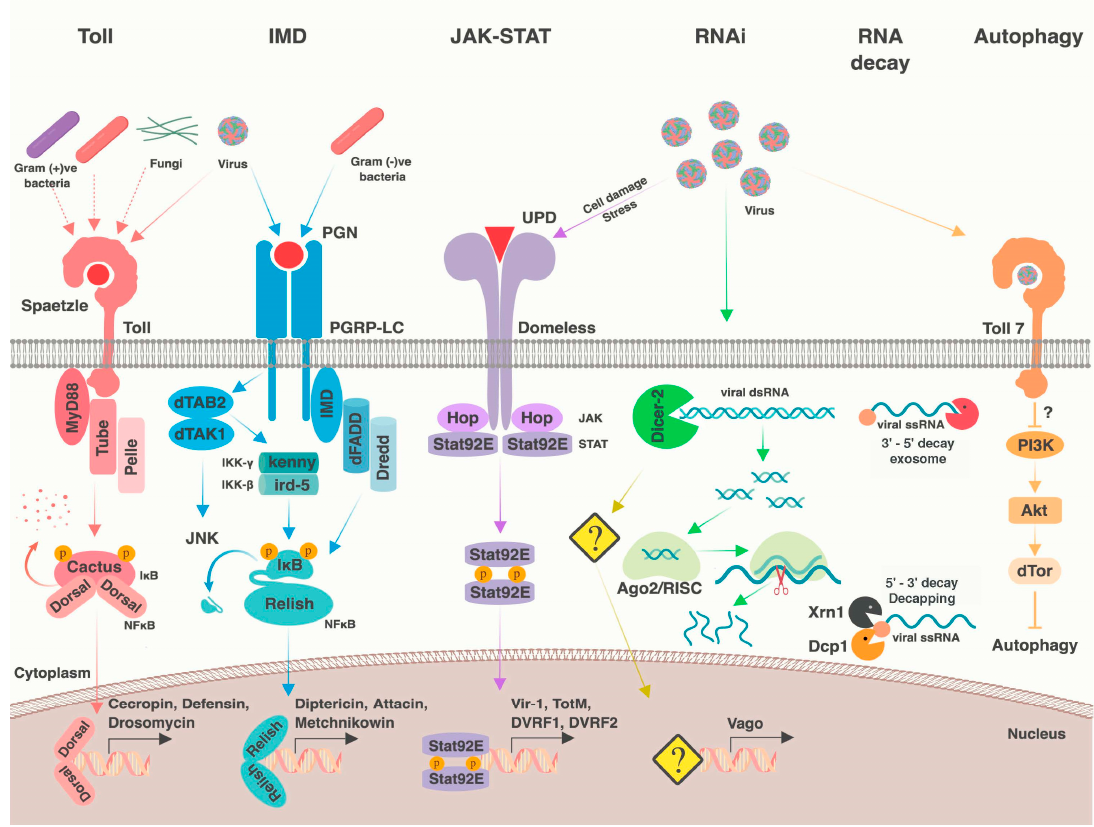
Figure 1. Antiviral innate immune pathways in dipteran insects. Toll pathway : Detection of pathogen-associated molecular patterns (PAMPs) by pathogen recognition-receptors leads to the proteolytic maturation of Spätzle, which binds to and activates Toll (dotted arrows). Activated Toll recruits adapter proteins MyD88, Tube and Pelle which targets Cactus for proteasomal degradation via phosphorylation. Cactus degradation releases the transcription factor Dorsal (Rel1 in mosquitoes) or Dif (Dorsal-related immune factor) when activated in response to bacterial infection. These translocate to the nucleus and activates the transcription of Toll pathway-regulated genes (e.g., cecropin , defensin and drosomycin ). IMD pathway : Gram-negative PAMPs (e.g., peptidoglycan) bind to peptidoglycan recognition protein, PGRP-LC (or PGRP-LE) and signal through the adapter molecules IMD (Immune Deficiency) and dFADD ( Drosophila Fas-associated death domain). This stimulates the caspase Dredd (Death-related ced-3/Nedd2-like protein), dTAK1 ( Drosophila transforming growth factor β -activated kinase 1), and dTAK1 adapter protein dTAB2 (TAK1-binding protein 2). These proteins signal through the JNK pathway, and activate the I κ B kinases kenny and ird-5, which phosphorylate the C-terminal tail of the transcription factor Relish (Rel2 in mosquitoes), leading to its subsequent activation via proteolytic cleavage by Dredd. Activated Relish translocates to the nucleus and drives the expression of genes regulated by the IMD-pathway (e.g., diptericin , attacin and metchnikowin ). JAK-STAT pathway : Virus infection, possibly through induction of stress or cellular damage, triggers the activation of the JAK (Janus kinase)-STAT (signal transducers and activators of transcription) pathway, which begins with the binding of a cytokine of the unpaired (upd) family to the dimeric receptor, domeless. Subsequently, the receptor-associated JAK-tyrosine kinase hopscotch phosphorylates the cytoplasmic tail of domeless, leading to the recruitment of Stat92E. After Jak-mediated phosphorylation, Stat92E proteins dimerize and shuttle to the nucleus to activate the transcription of genes such as vir-1 , TotM , DVRF1 and DVRF2 . RNAi pathway : Double-stranded RNA derived from virus replication intermediates are recognized and processed by Dicer-2 into 21 nt small-interfering RNAs (siRNAs), which are then loaded onto an Argonaute-2 (Ago2)-containing RNA-induced silencing complex (RISC). This complex degrades one of the two strands and uses the other strand as a guide RNA to target complementary viral sequences. Dicer-2 can also activate the expression of the cytokine Vago through an unknown pathway (visualized as ‘?’ in the figure). RNA